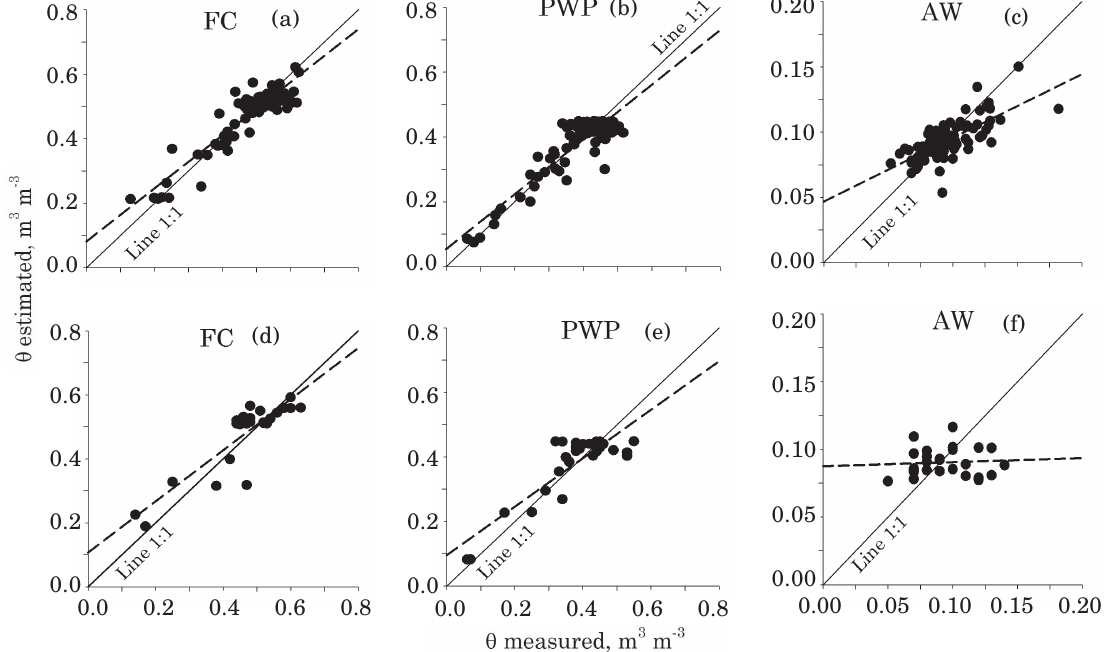
Figure 8. Field capacity (FC), permanent wilting point (PWP) and available water content (AW) measured and estimated by PTFs of the simple model: Particle size distribution of the soil, organic matter and their interactions for the generation database (a, b, c) and validation database (d, e, f) for subsurface horizons of soils in the State of Santa